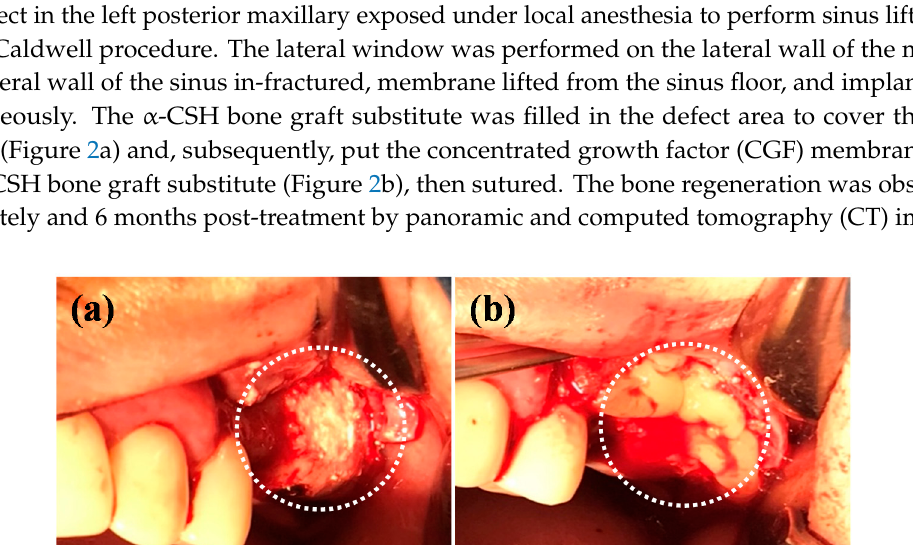
Figure 1. The position of the implanted material in the rat’s right hind leg bones: ( a ) before implantation and ( b ) after implantation (as indicated by the black dash line).